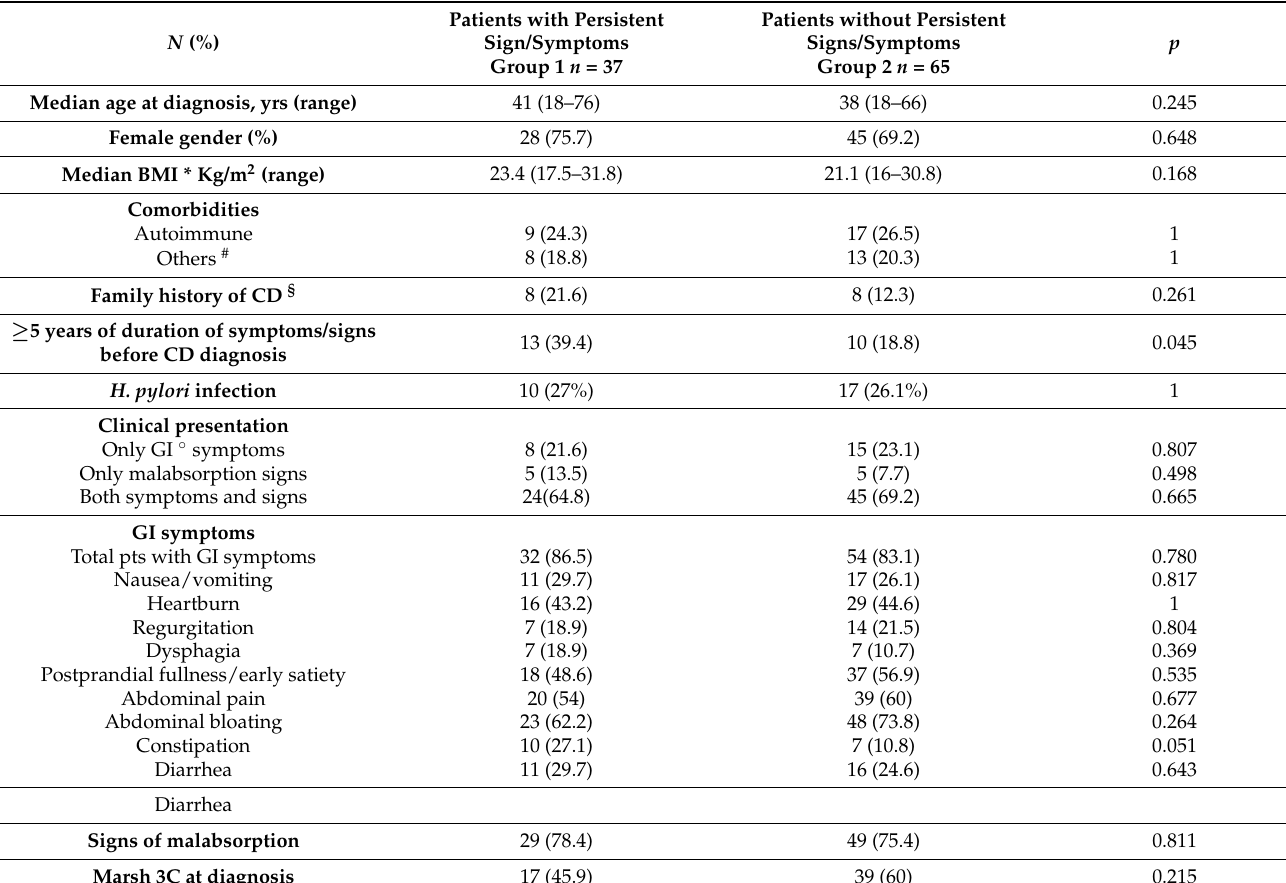
Table 1. Comparison of main characteristics of included patients at the time of CD diagnosis with respect to presence or absence of persistent GI symptoms/malabsorption signs.